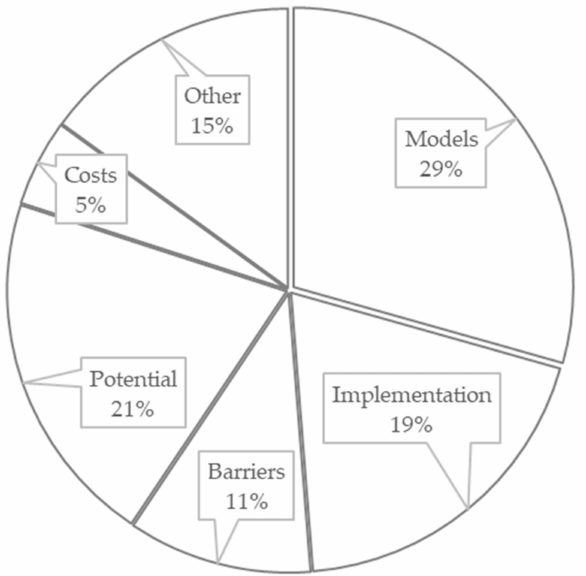
Figure 3. Areas of contributions within the selected demand response